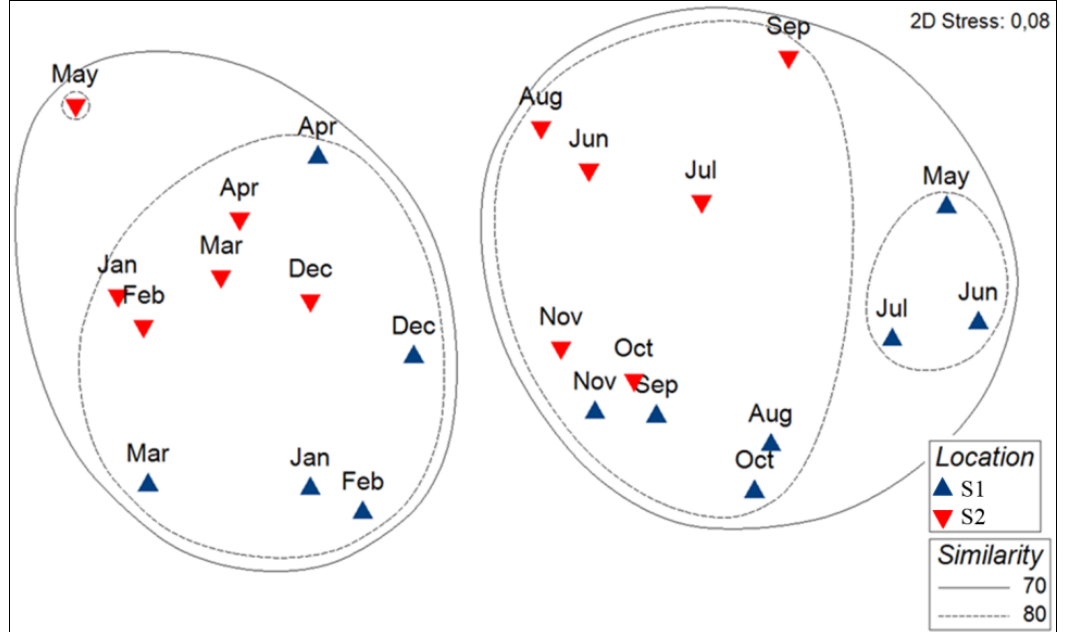
Figure 6. MDS of pigment composition of phytoplancton assemblages of S1 (Calvi, in blue) and S2 (Bastia, in red) coupled to a cluster analysis. Solid and dashed lines represent the principal clusters identified at, respectively, a 70% and 80% Bray–Curtis similarity.